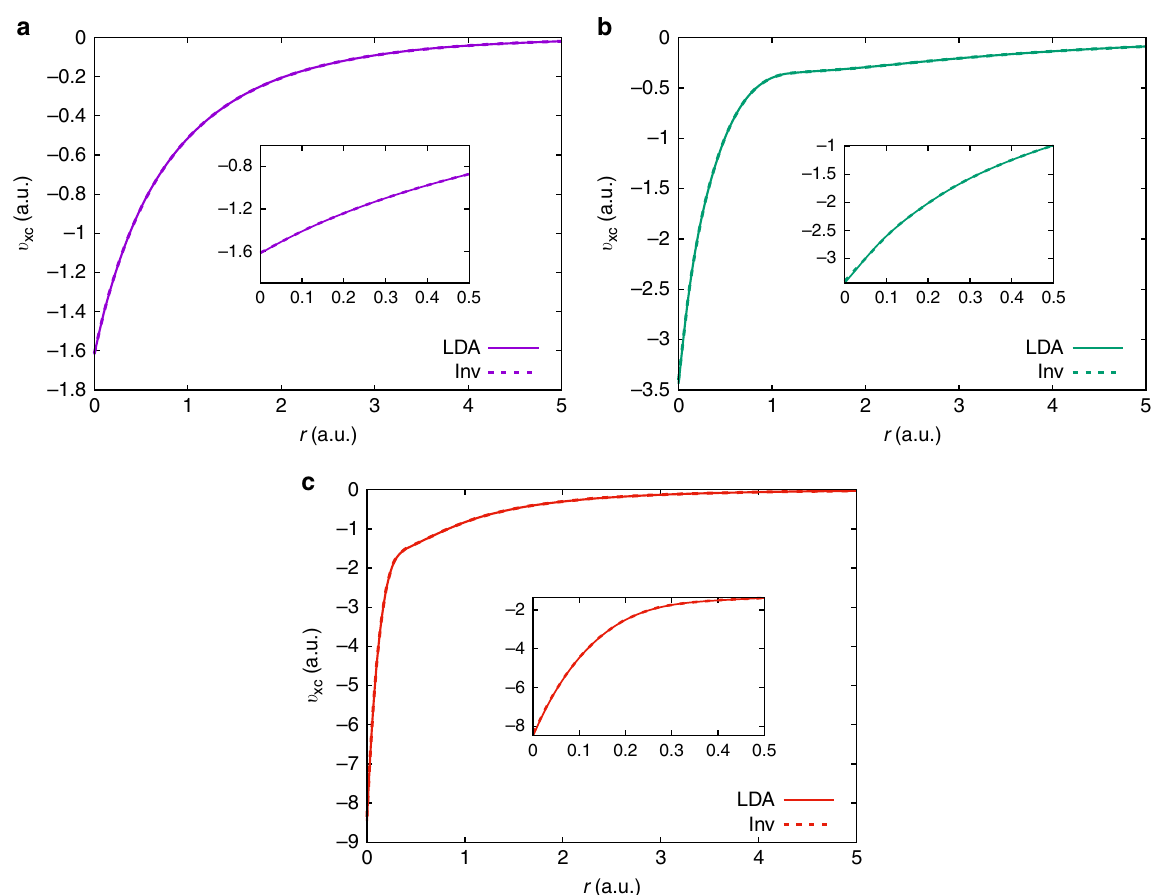
−1.2−1−0.8−0.6−0.4−0.200.20.4 Fig. 4 Artifact of Gaussian basis-set-based density. The exchange- correlation potential ( v ) is evaluated from inverse DFT, using ρ xc data obtained from a Gaussian basis-set-based con fi guration interaction (CI) calculation for the equilibrium hydrogen molecule ( H 2 ð eq Þ ). The lack of cusp in ρ at the nuclei induces wild oscillations in the v obtained xc data through inversion. The two atoms are located at r ¼ ± 0 : 7 xc